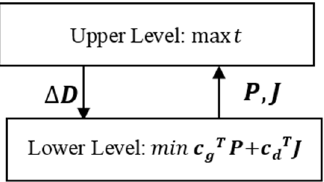
Figure 1. Bilevel model for assessing the risk of a transmission line.